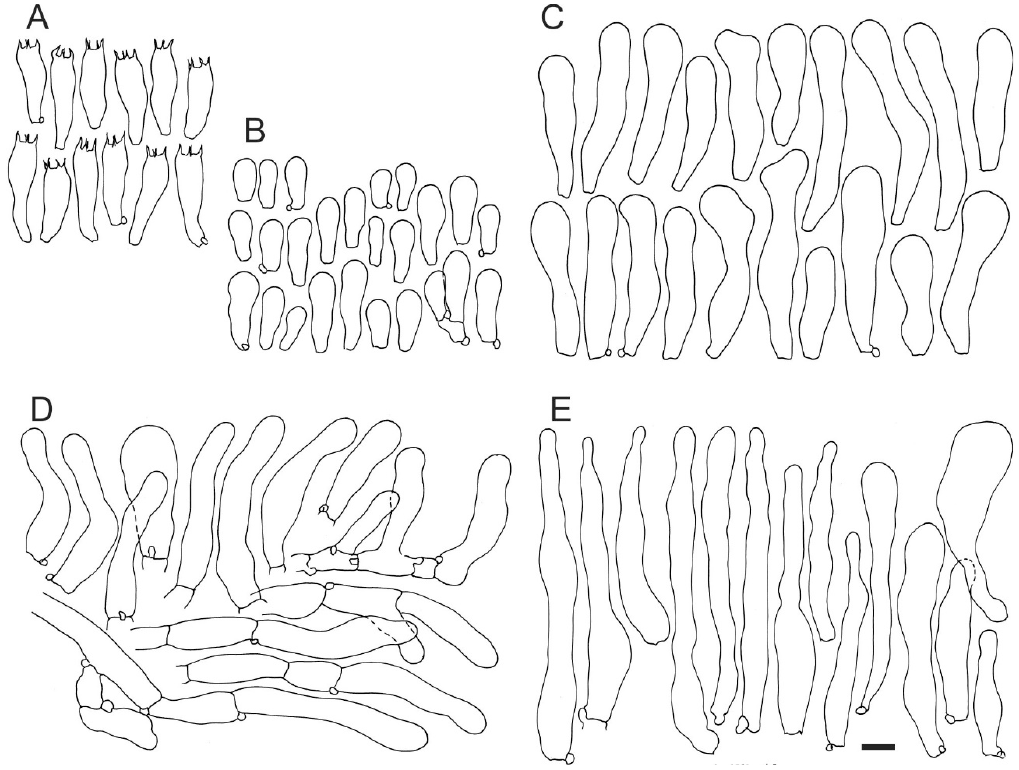
Figure 8. Microscopic elements of Crepidopus pini (SLO 2579). ( A ) basidia, ( B ) basidiola, ( C ) cheilocys- tidia, and ( D , E ) terminal elements in pileipellis. Scale bar = 10 µ